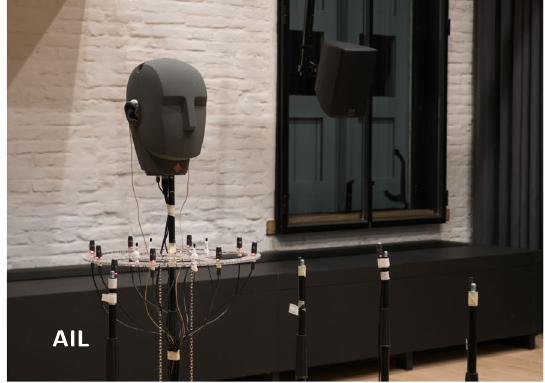
Fig. 7 A combination of the microphone configurations M1 and M2 as used at the